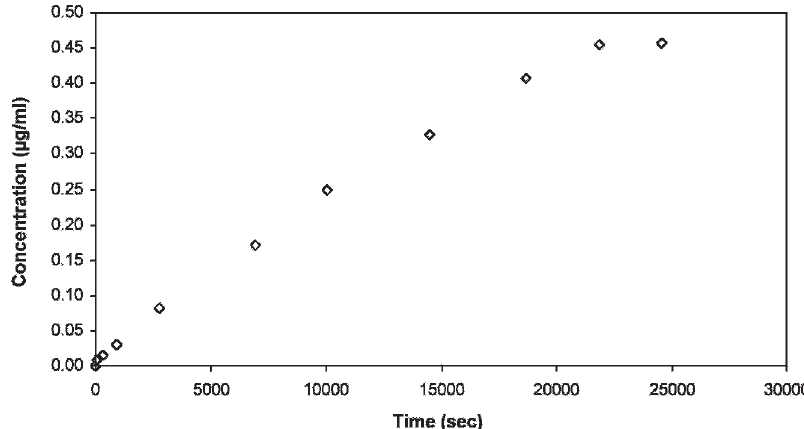
Figure 3 - Concentration curve of Dextran-FITC in water (from Run 8).